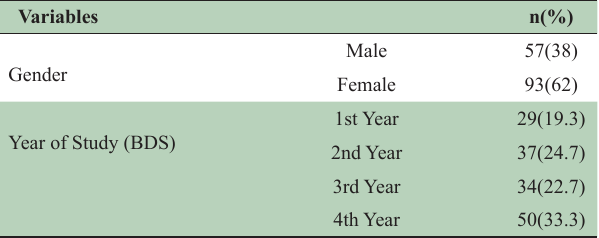
Table-I: Demographic Details of Participants.